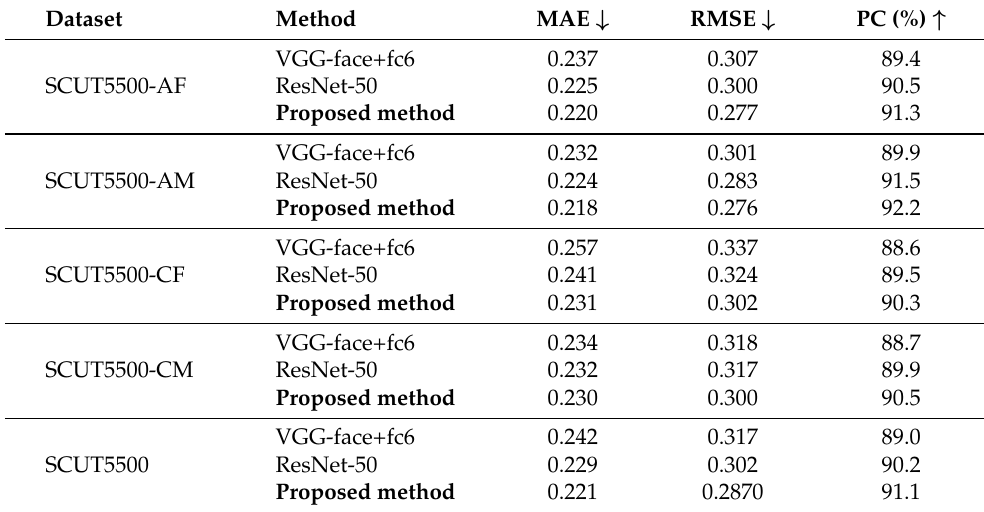
Table 3. Semi-supervised face beauty prediction.